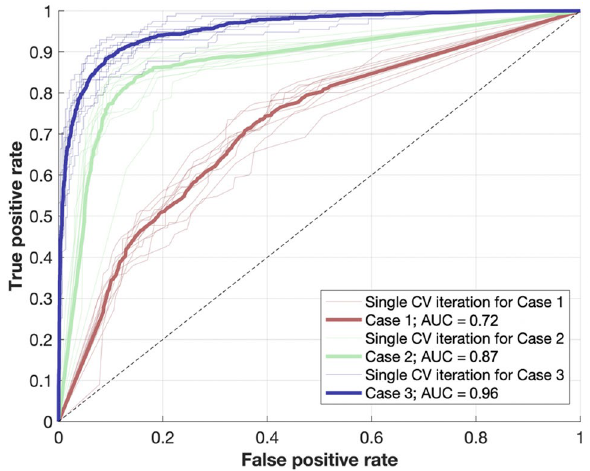
Figure 8. The receiver operator curves representing the performance of the automatic platform for all considered cases; the narrower, transparent lines present results from a single specific iteration of the hold-out cross-validation. AUC = area under curve, CV =